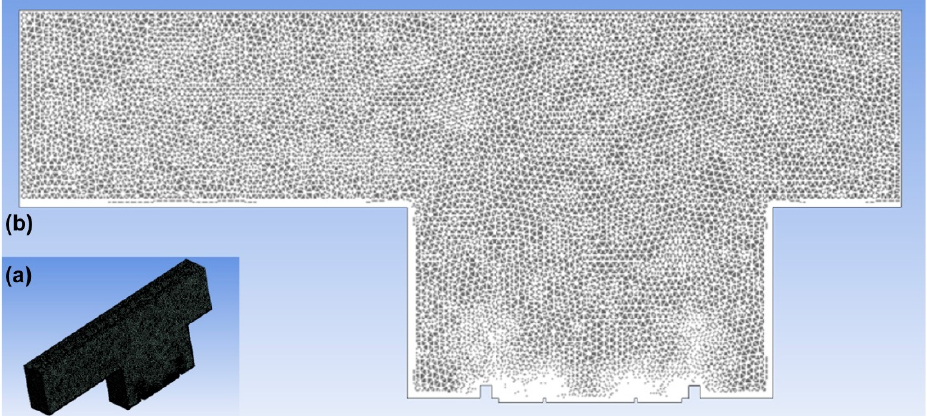
Figure 2. Grid example for modeling F3 . ( a ) The model was constructed with surface and spatial grids of different sizes. The surface grid-particle inlet and walls formed a dense grid of 0.15 m; the spatial grids were applied as a tetrahedral grid model and then converted to polyhedrons. ( b ) Black- and-white reversal of the cross-section of the grid model. The white area is the region of interest with a dense grid. Table 2. Summary of key simulation parameters.